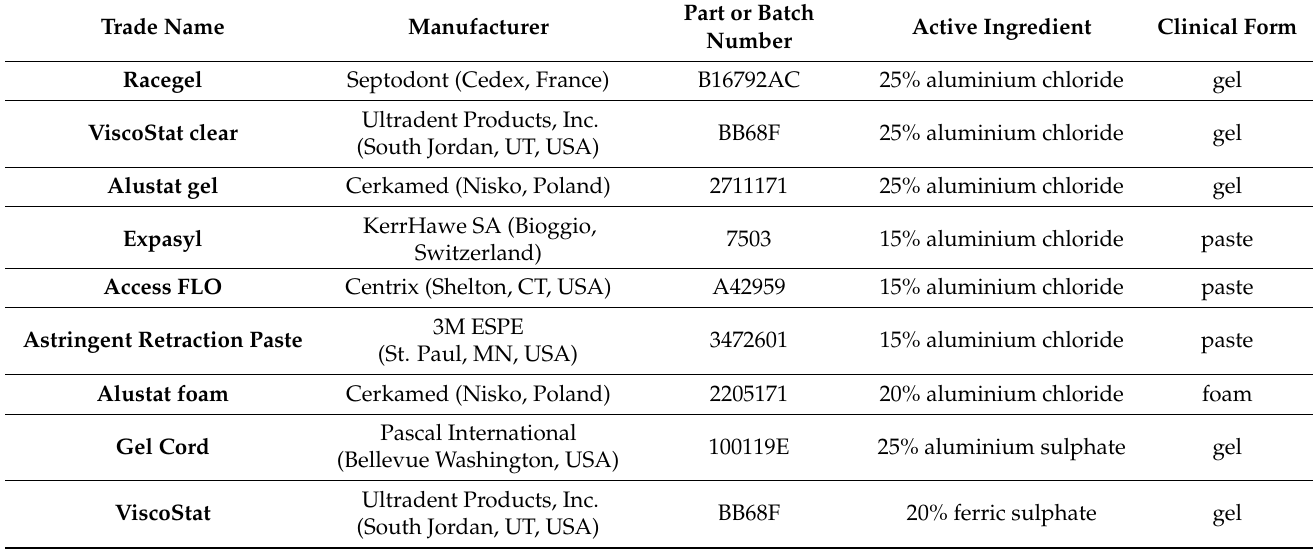
Table 1. Characteristics of the studied gingival retraction/displacement